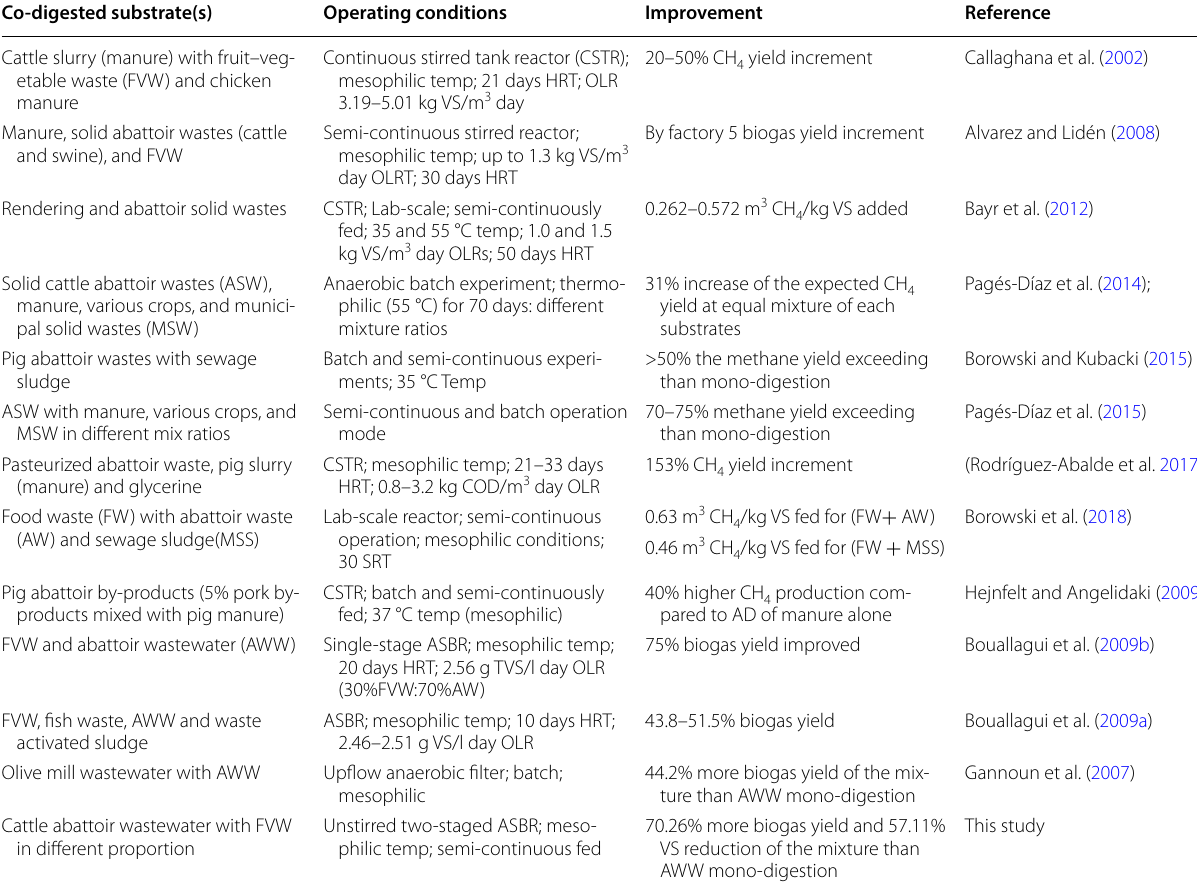
Table 1 Performance of anaerobic co-digestion abattoir wastes with different substrates Co-digested